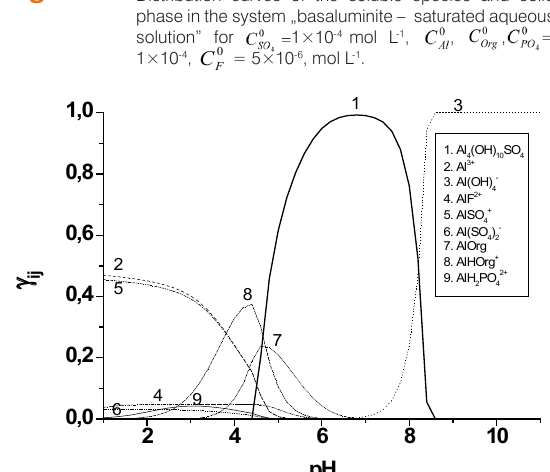
Fig. 9 is illustrated the variation of the solute mole fraction of the solid phase - basaluminite, in function of pH and . One can observe the areas of the mineral existence, e.g . the areas of the heterogeneous system, coincide with the areas of the thermodynamic stability of this mineral (Fig. 1), at the same time the values grow up with the increase of .